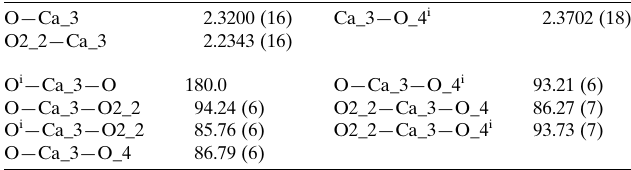
Table 1 Selected geometric parameters (A˚ , (cid:5) ) for I .